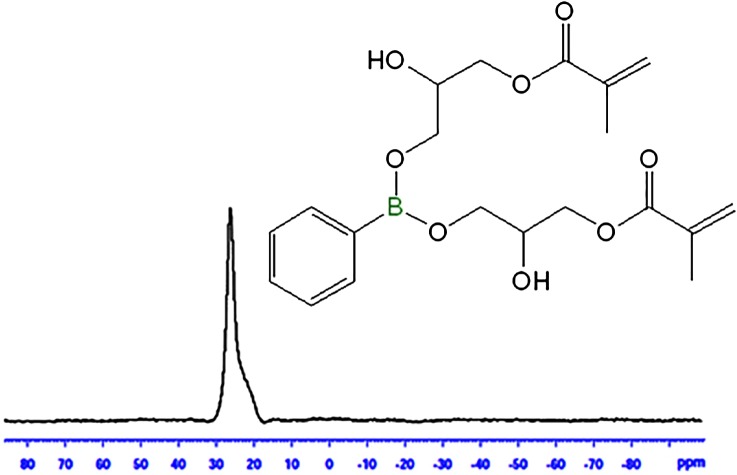

11B NMR of boron BARD.